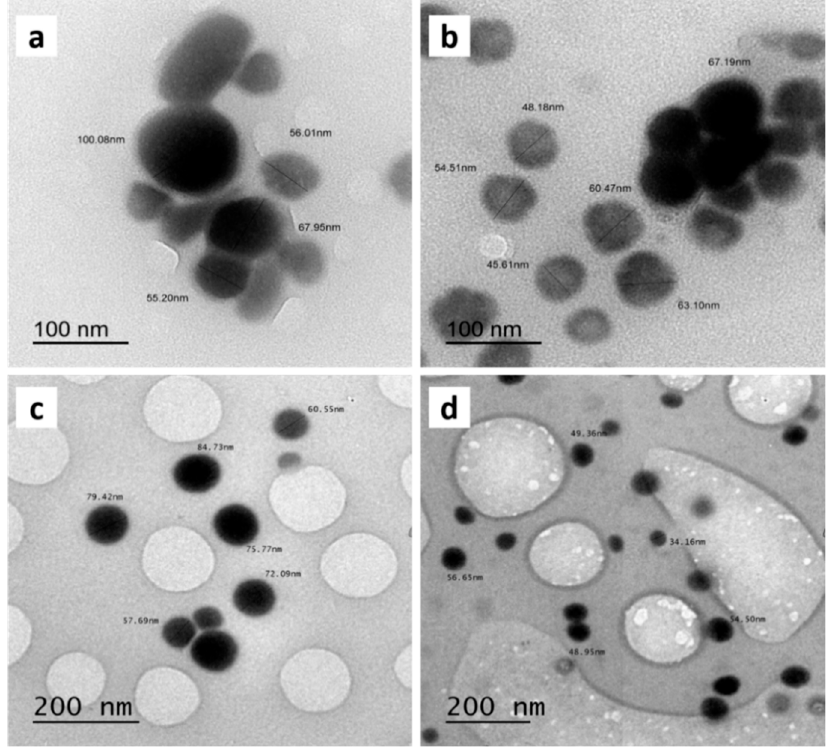
Figure 1. TEM images of synthesized Se ‐ NPs on different concentrations: ( a ) 12.5 mM, ( b ) 25 mM, ( c ) 37.5 mM and ( d ) 50 mM.